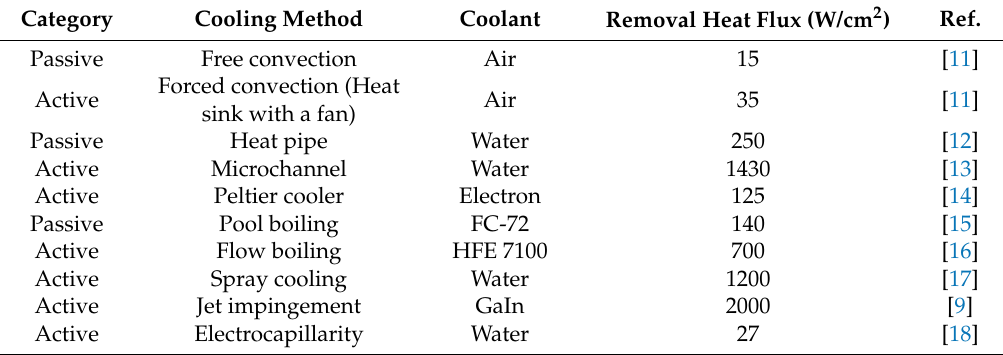
Figure 1 . Trends of ( a ) the number of transistors per microprocessor chip, clock speeds, and ( b ) the size of machines every 10 years. Reproduced with permission from [3], published by Nature, 2016. Table 1. Thermal management methods for electronic devices and systems.